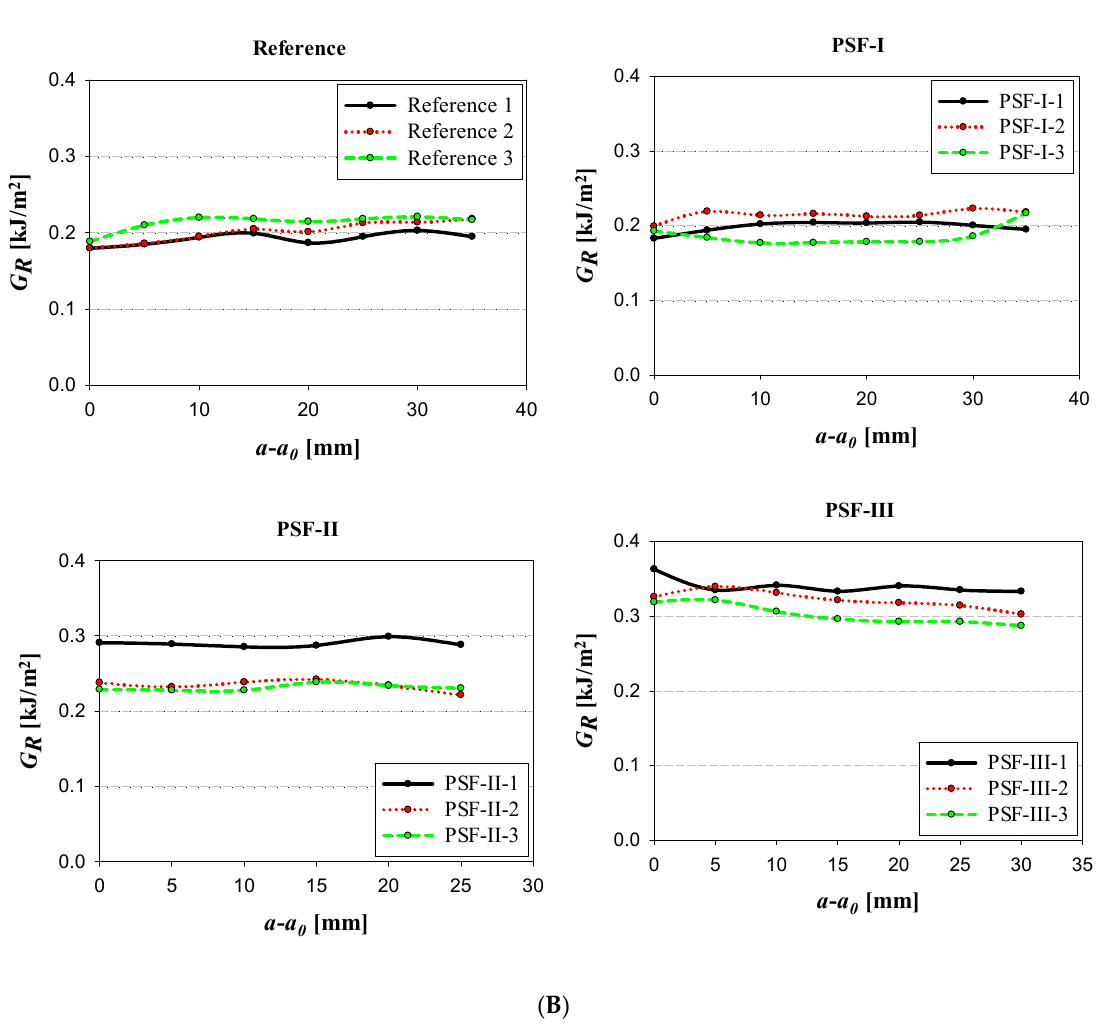
Figure 3. ( A ) The load–displacement curves for the reference and PSF-modified specimens, and ( B ) the R-curve for all the specimens.